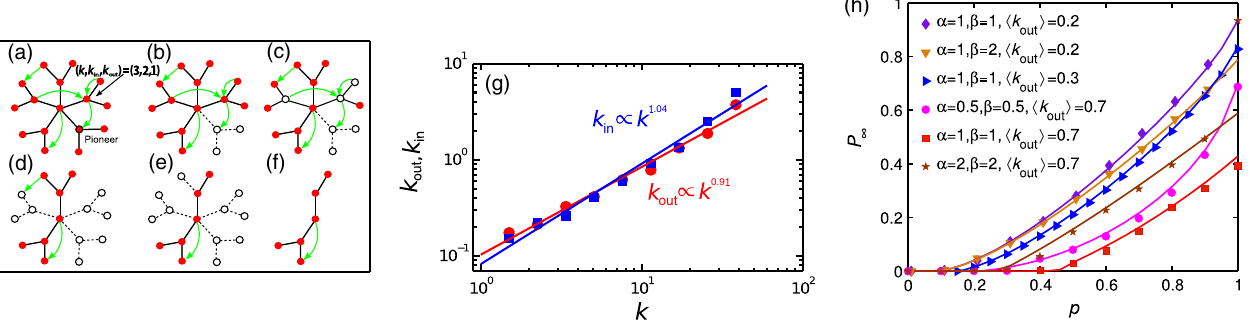
FIG. 3. Modeling the cascading process of followers. (a) Sketch of the model network (considered as the giant component) with undirected connectivity links (solid black links) superimposed by a network of directed influence links (green links). The nodes are ; k characterized by ð k; k , as indicated in the sample node. The node indicated by the black circle is the pioneer moving to another in out Þ field and is therefore removed first. (b) First connectivity-percolation process: Two additional nodes are removed (open circles) since they are not connected anymore to the giant component after the removal of the pioneer node in (a). (c) Influence-induced process: One extra node is removed due to the influence link pointing to the pioneer that induces two more influence departures, as indicated. Such removals induce a cascading effect, since now other nodes are disconnected from the giant component, a step that is considered next. (d) Percolation-connectivity process: Three extra nodes are disconnected from the giant component and are therefore removed. (e) Influence-induced percolation process: A final node is removed due to the influence link to one of the nodes removed in (d). (f) At the end of the cascade, the giant component is reduced to six nodes. (g) Empirical study of local correlations between the influence degree ∝ k α and k ∝ k β with α ¼ 0 . 91 (cid:1) 0 . 04 and and the connectivity degree averaged over all APS networks. We obtain k out in β ¼ 1 . 04 (cid:1) 0 . 05 . (h) Comparison between simulations and theoretical results. The symbols denote the simulation results, and the curves are the prediction of theory for P ∞ ð p Þ . We use a scale-free network with γ ¼ 2 . 5 and minimal degree 1. We first generate the connectivity network and then generate the correlated influence-directed links according to the connectivity degree of each node and ð α ; β Þ and calculate P ∞ ð p Þ by directly performing a percolation analysis on the network. Then, we calculate G ð x 1 ; x 2 ; x 3 Þ to obtain the theoretical predictions of Eqs. (B17) and (C10). We find that the theoretical results agree very well with